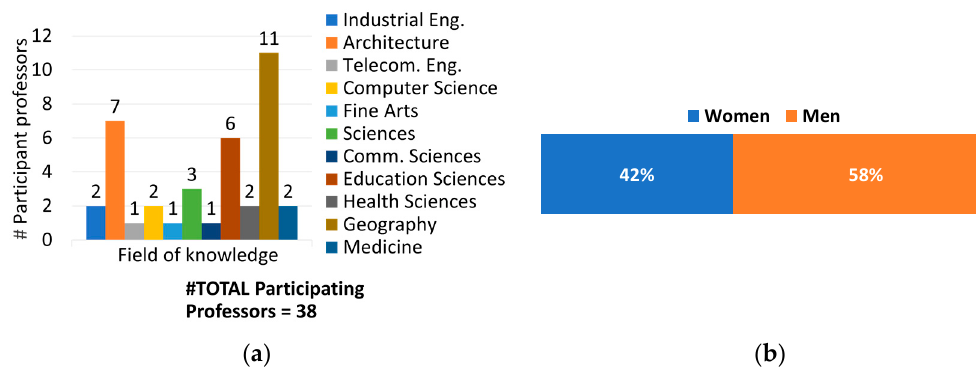
Figure 11. Professors in the project in relation to their field of knowledge ( a ) and gender ( b ).